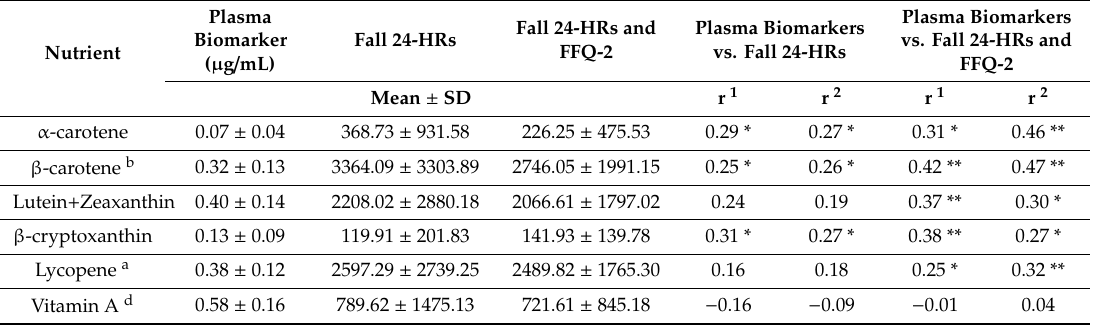
Table 4. Sensitivity analysis ( n = 67). Mean carotenoid intakes by average fall 24-HRs and FFQ-2 and nutrient plasma concentration and Spearman correlation coe ffi cients for subjects who have undergone blood tests ( n = 67).